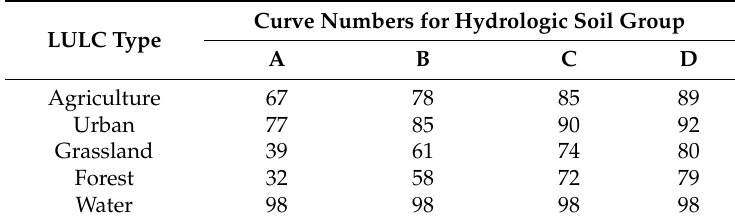
Table 1. The CN values of LULC types and hydrologic soil group used in the present study. Curve Numbers for Hydrologic Soil Group LULC Type